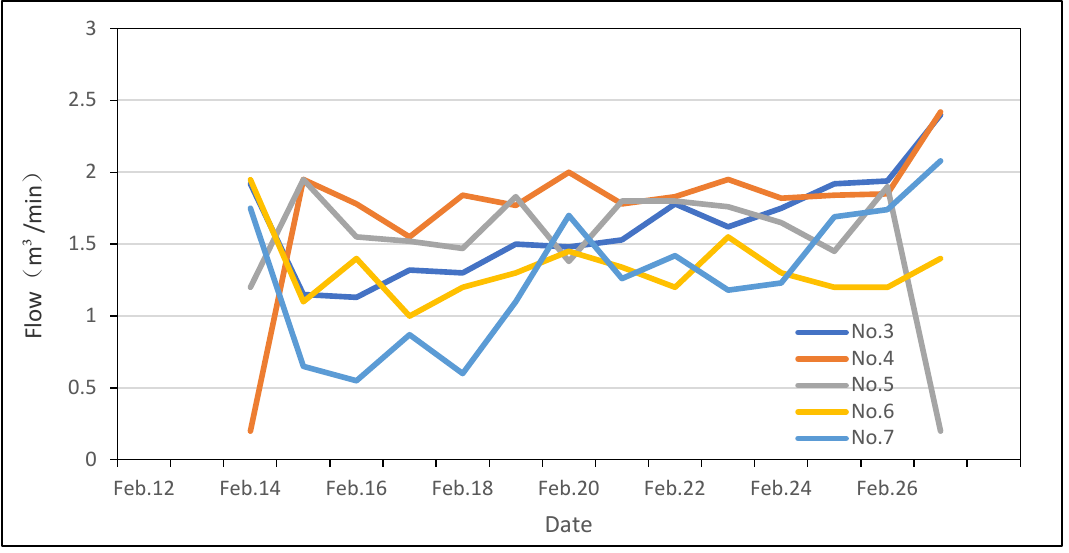
Figure 12. Gas flow curve of some boreholes in No. 8 drilling field of Lane XV1306.